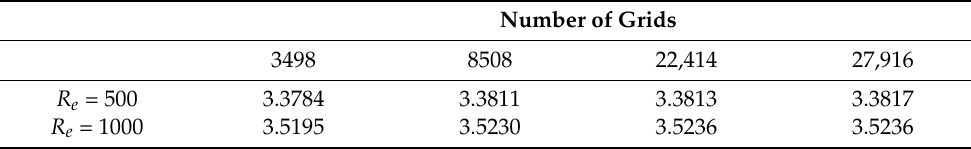
Table 2. Comparison between Nu avg for different grid